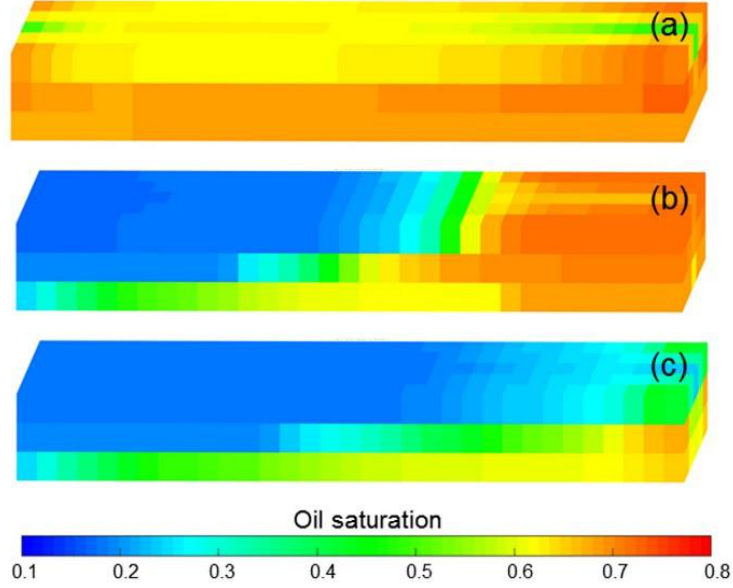
Figure 18. 3D remaining oil saturation distributions after ( a ) initial water flooding, ( b ) polymer flooding and ( c ) extended water flooding of Case 15.